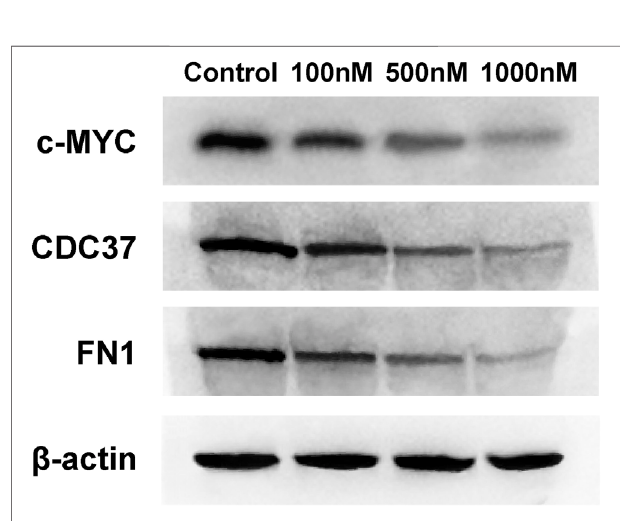
FIGURE11 | Celastrol inhibited core target expression in ovarian cancer cells. Western blot analysis of c-MYC, CDC37, and FN1 protein expression.